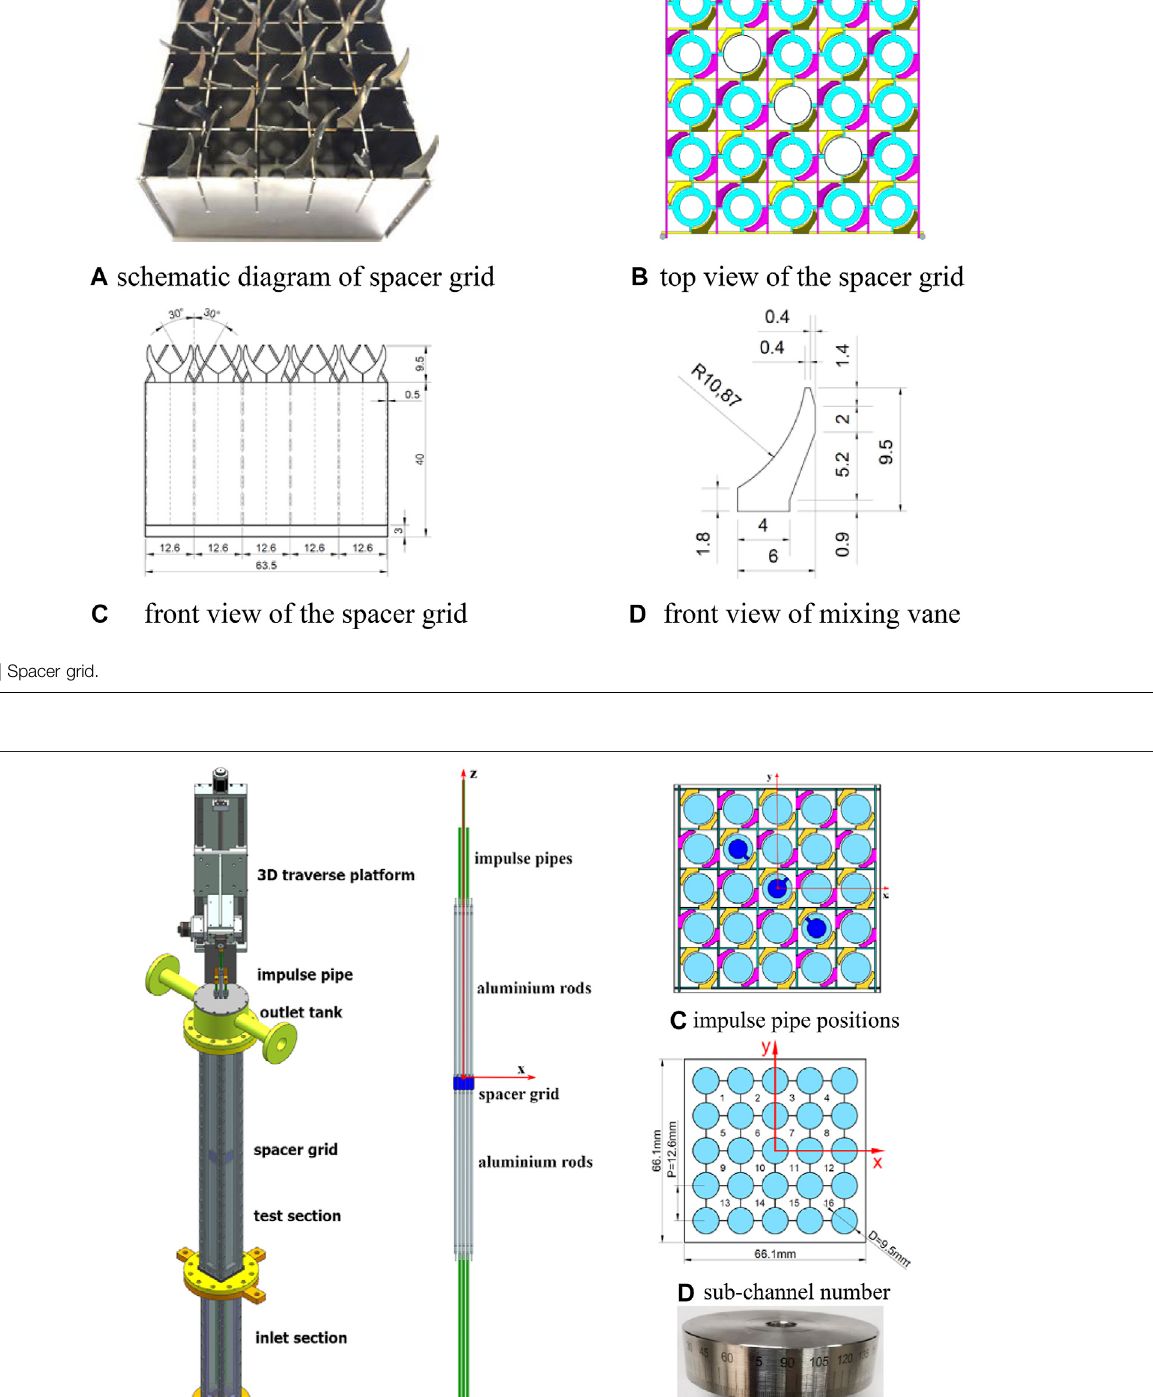
Frontiers in Energy Research |